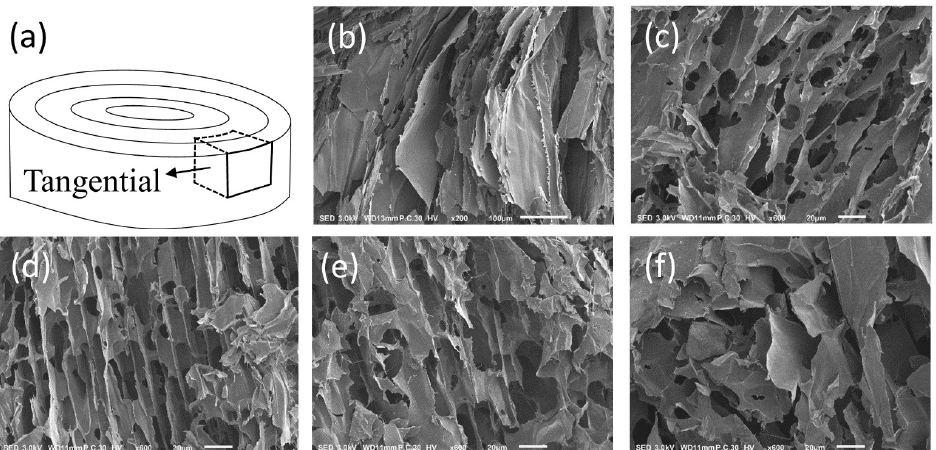
Figure 4. Cross-sectional SEM images of 3D printed aerogels in the tangential direction, vertical to the cold stage: ( a ) schematic of the direction of the observation and ( b – f ) SEM images of aerogels prepared from di ff erent XG:CNC ratios 0:1, 1:100, 1:50, 1:10, and 1:4, respectively.